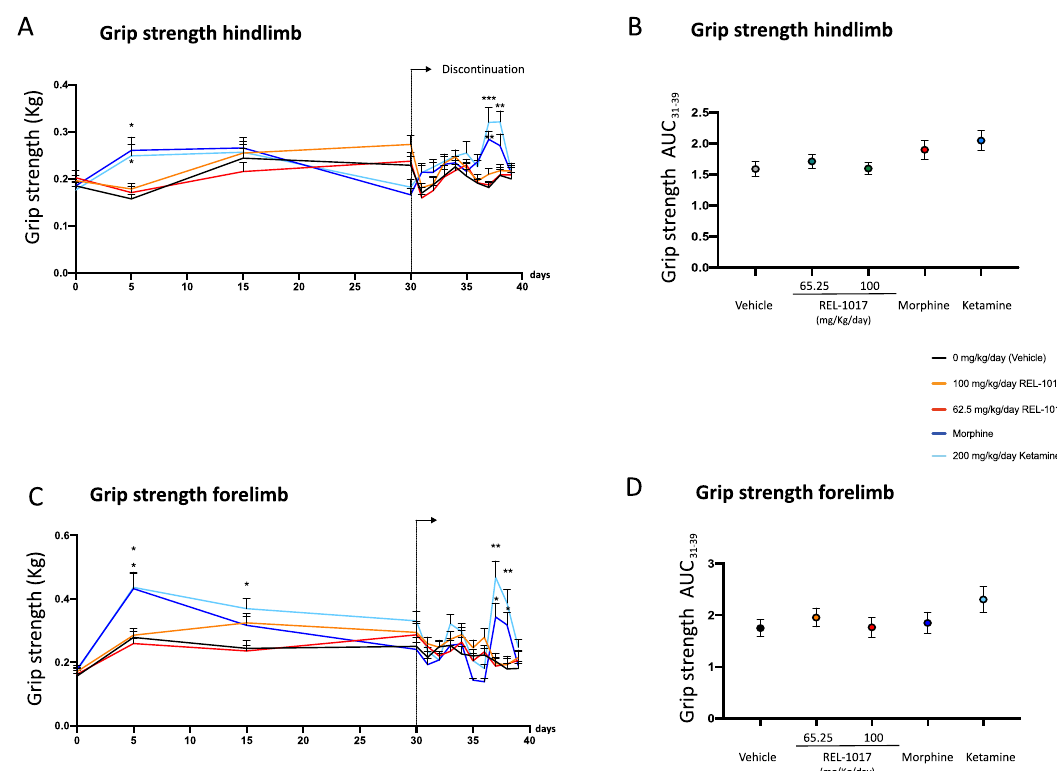
Figure 6. Discontinuation of chronic REL-1017 (esmethadone) administration did not cause modification in neuromuscular measures. Measurements of neuromuscular functions evaluated during the 9 days of discontinuation in rats treated for 30 consecutive days with morphine (dark blue line) demonstrated statistically significant changes in ( A ) hindlimb and ( C ) forelimb grip strength compared to vehicle (black line) and REL- 1017 (yellow and red lines **p < 0.01; ***p < 0.001; at days 7 and 8). Ketamine-treated rats (light blue) showed significant changes in ( A ) hindlimb grip strength compared to vehicle and REL-1017 (*p < 0.05 at day 7). No differences were observed in the AUC values of hindlimb ( B ) and forelimb ( D ) grip strength measured over the time interval 31–39 days between morphine-treated rats (blue dot), vehicle (black dot) and REL-1017-treated rats (yellow and red